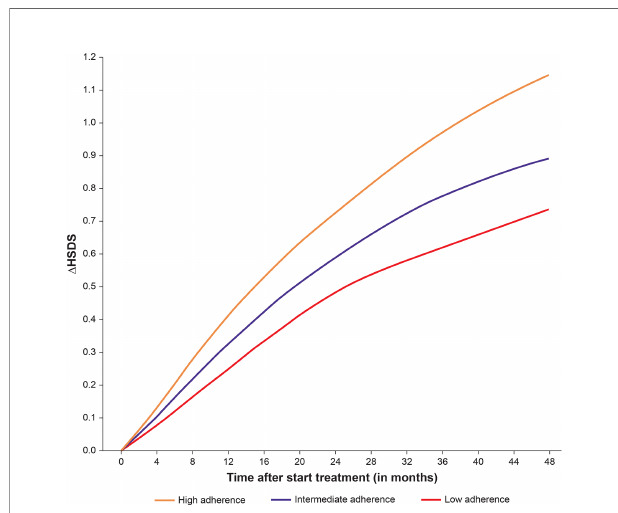
FIGURE 6 | Mean catch-up growth ( D HSDS) between 0 – 48 months strati fi ed by high, intermediate, and low adherence.